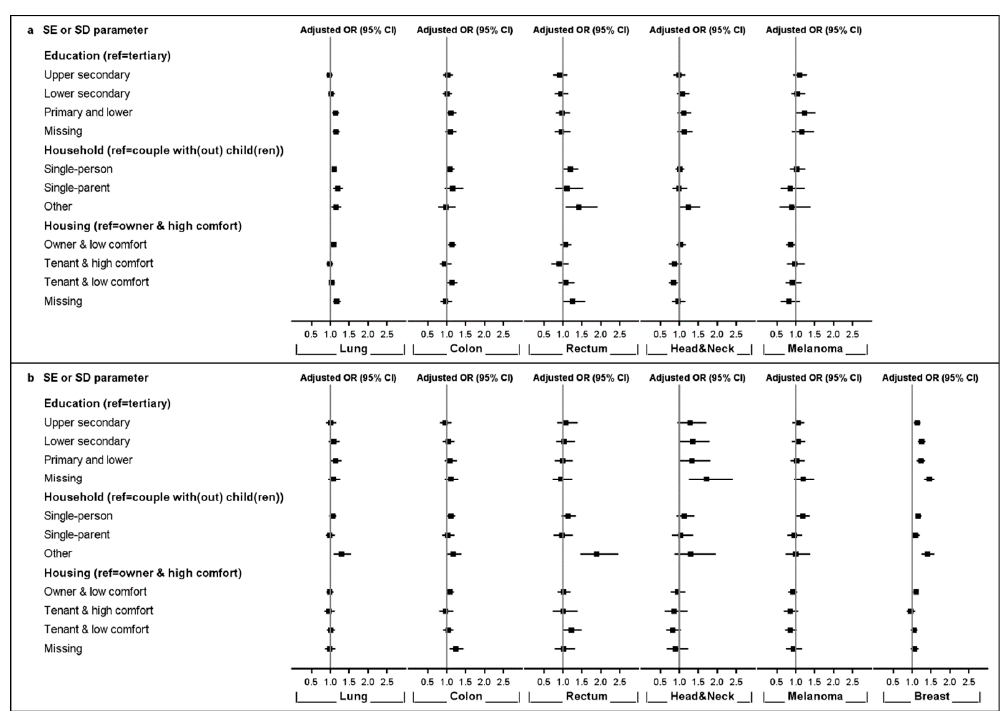
Figure 2. Adjusted odds ratios (ORs) with a 95% confidence interval (CI) for being diagnosed with unknown stage by socio-economic (SE) or -demographic (SD) parameters, cancer type, and sex; 2004–2013. Upper panel ( a ): men; lower panel ( b ): women.